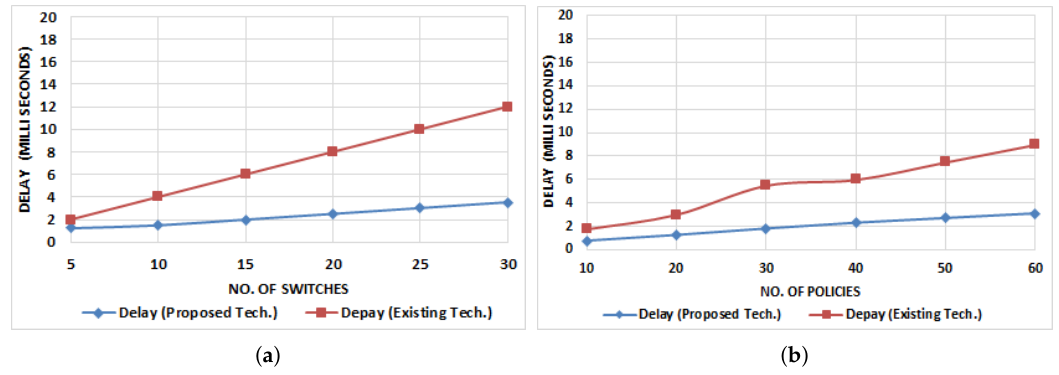
Figure 22. SPD for near the Destination policy Implementation Scheme. ( a ) End-to-End Delay Computation when number of switch is varying and number of polices is constant; ( b ) End-to-End Delay Computation when the number of policies is varying and number of switches is